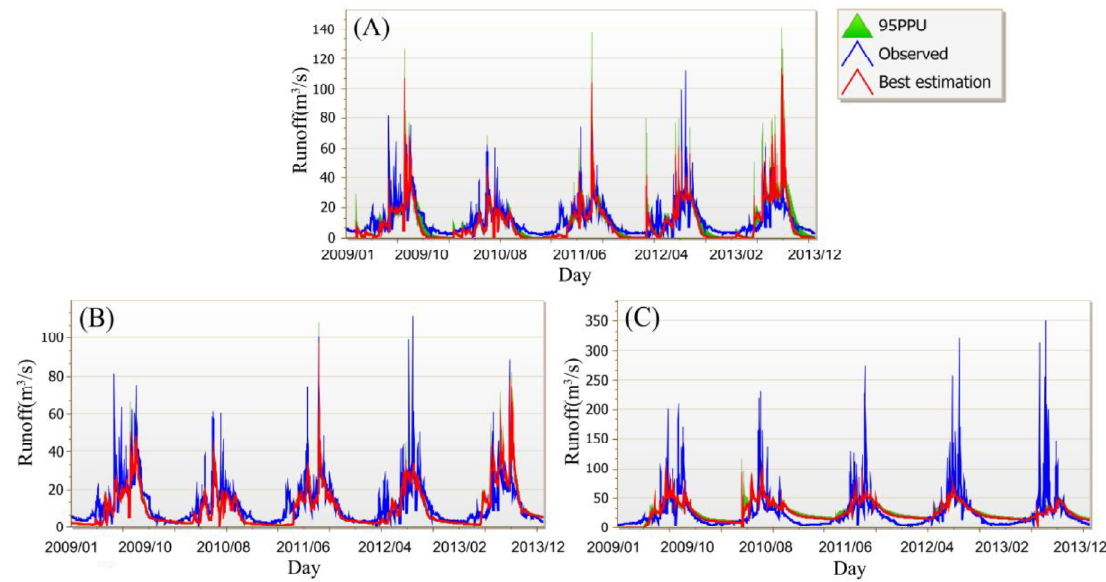
Figure 10. Daily runoff simulation results of three different modes at ZhaMashenke control station from 2009 to 2013: ( A ) CMADS + SWAT mode; ( B ) TWS + SWAT mode; ( C ) CFSR + SWAT mode.